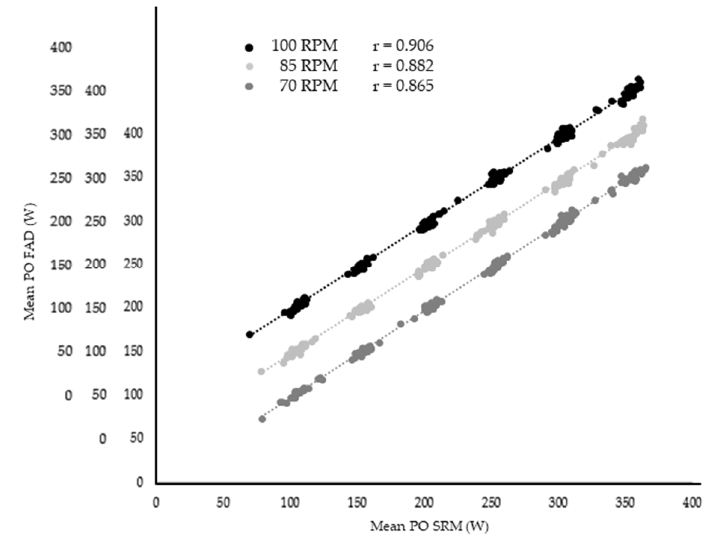
Figure 3. Pearson’s correlation coefficient between Favero Assioma Duo (FAD) and SRM power meter under three different cadences during block one. Abbreviation: PO, power output. There was a low bias between the PO values of the SRM and FAD in block one ( − 2.29 W at 70 rev · min − 1 , − 1.78 W at 85 rev · min − 1 and − 2.41 W at 100 rev · min − 1 ) (Figure 4a–c). A